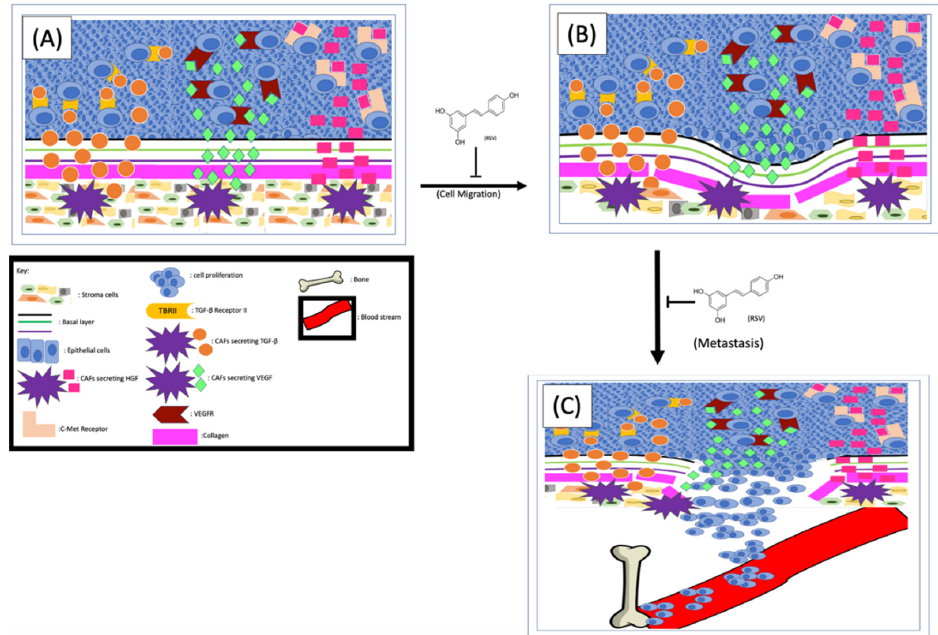
Figure 3. RSV inhibits EMT and cancer cell metastasis. The CAFs-released TGF- β , VEGF and HGF ( A ) interact with their corresponding receptors on cancer cells and enhance EMT processes ( B ). The cancer cells metastasize from their primary site ( B ) to the bone ( C ). RSV is capable of inhibiting prostate cancer metastasis by repressing EMT and cancer cell migration/invasion.